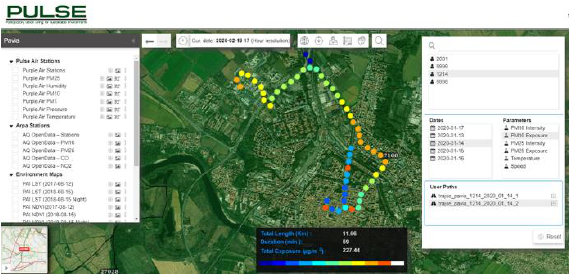
Figure 23. PULSE WebGIS screenshot where personal expositor trajectory is